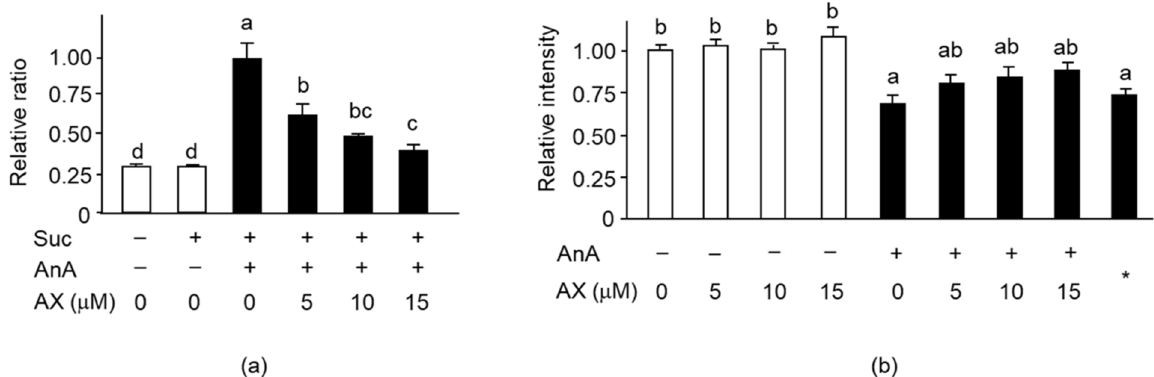
Figure 7. Effect of AX on mitochondrial superoxide levels and MMP in AnA-treated Sol8 myotubes: ( a ) The rate of superoxide formation in AX-treated Sol8 myotubes was assessed using dihydroethidium (DHE) fluorescence. Succinate and AnA were used as respiratory complex II substrate and complex III inhibitor, respectively; ( b ) The quantitative matrix metalloproteinase (MMP) values were calculated based on the ratio of fluorescence intensity values (JC-1 dye). Data are represented as mean ± S.D. ( n = 8). Different letters indicate significant differences ( p < 0.05) based on the one-way ANOVA and Tukey’s test. “−” represents DMSO; *, CCCP; Suc, succinate; AnA, antimycin A. ROS production and MMP levels experiments are representative of at least three independent studies.